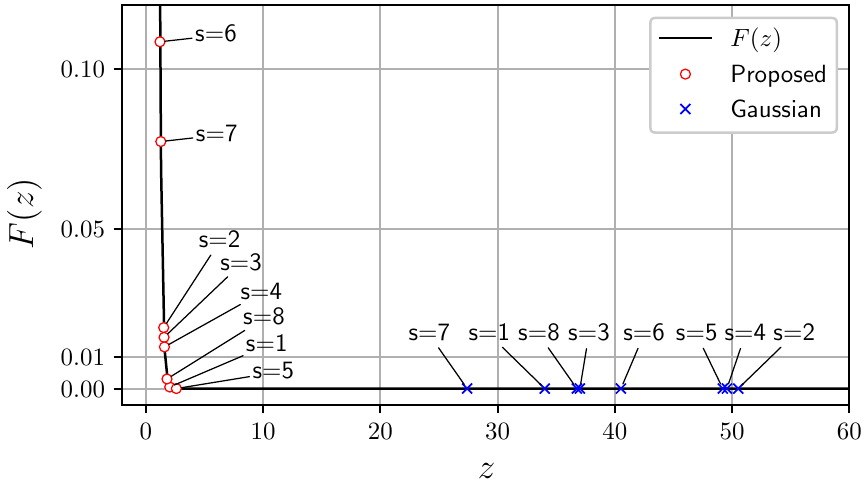
Figure 6. Kolmogorov–Smirnov (KS) testing results. The solid curve plots F ( z ) , the KS statistic cumulative distribution function (CDF). The small circles indicate the p -values between measured P ( s ) and our proposed P ( s ) , and the cross marks indicate those between P ( s ) sim